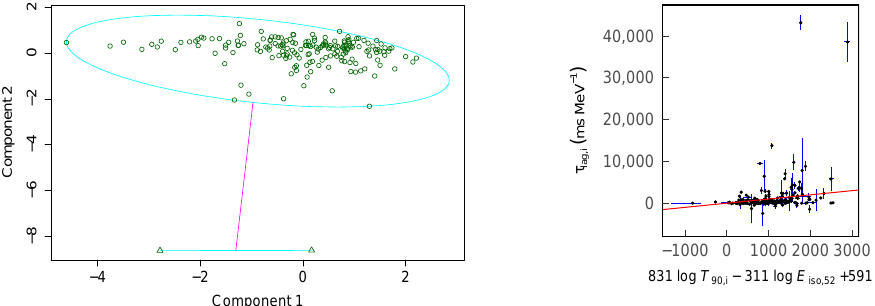
Figure 4. Similar to Figure 1, with the three parameters being τ lag,i , T 90,i and E iso,52 . The outliers are GRB 980425B and 030528A. The linear regression result is τ lag,i = ( 831 + 126 − ) . The adjusted R 2 is 0.07. log E iso,52 + ( 591 + 24 − 58